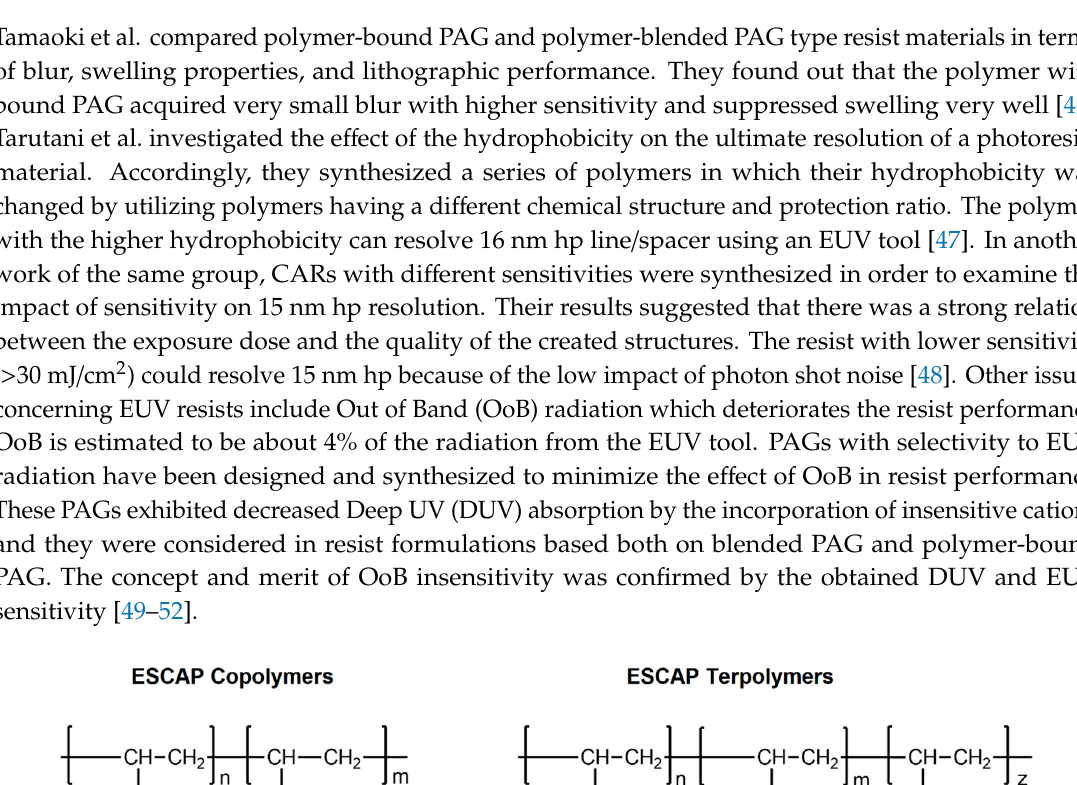
Figure 4. Fluorinated PAGs especially designed for EUV ( upper row ) and traditional PAGs ( lower row ) that were used for comparison in epoxy-based resist formulations. Adapted from [43], with permission from John Wiley & Sons, 2020.